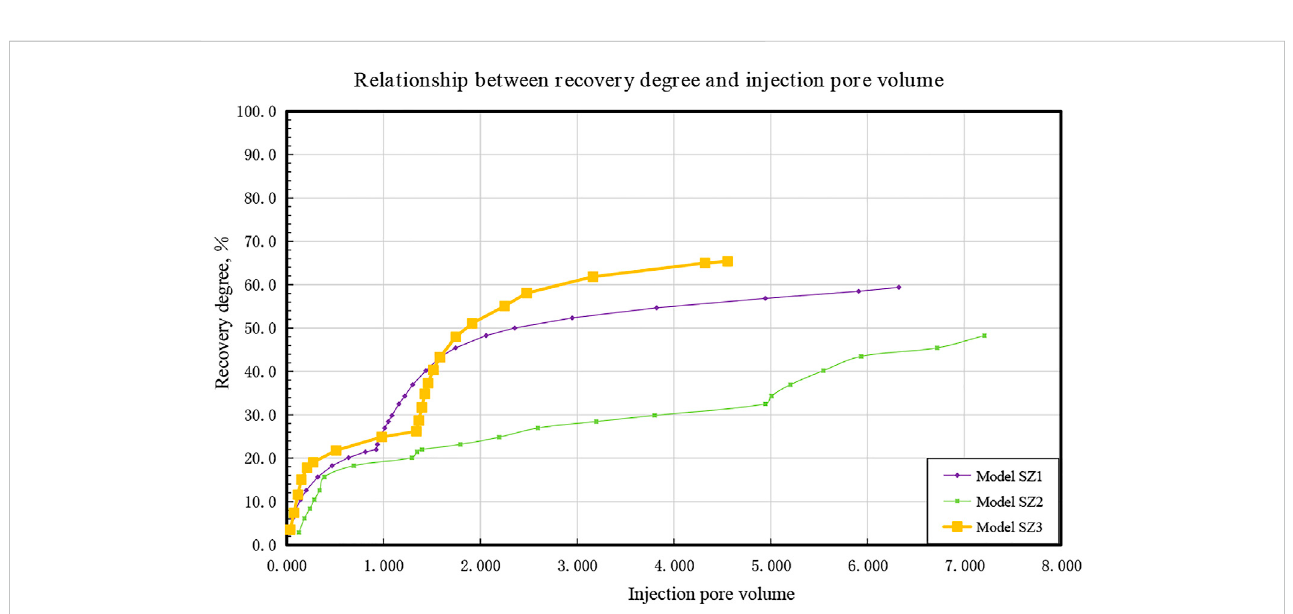
FIGURE 5 Relation between recovery and injection pore